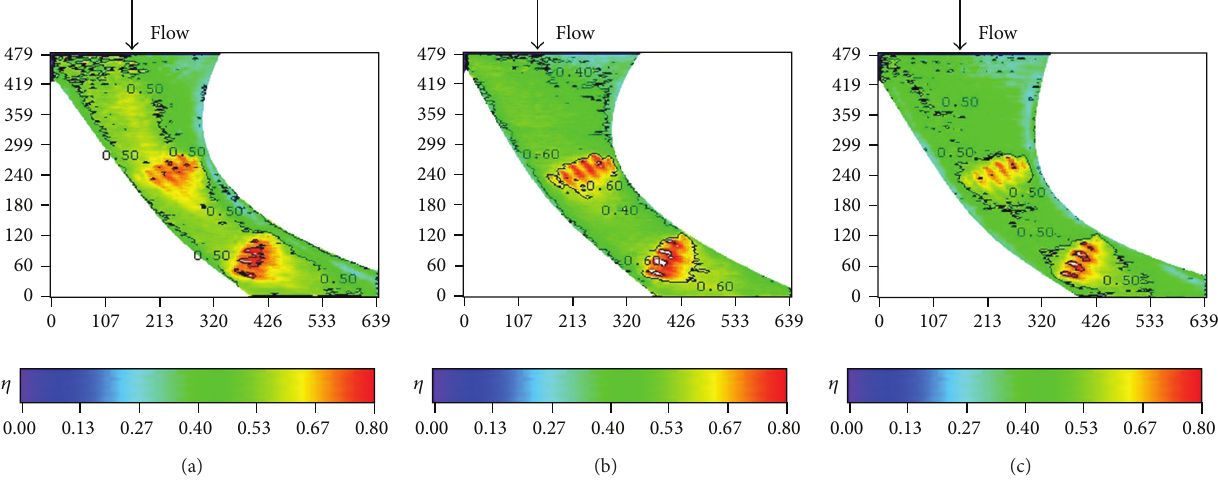
Figure 22: Effect of turbulence intensity on local effectiveness for backward-facing stepped endwall (Re = 124000 , 𝑀 = 2 , and 𝑆/𝐶 = −4 %). (a) T . I . = 1.8 %. (b) T . I . = 7 %. (c) T . I . = 12 %.